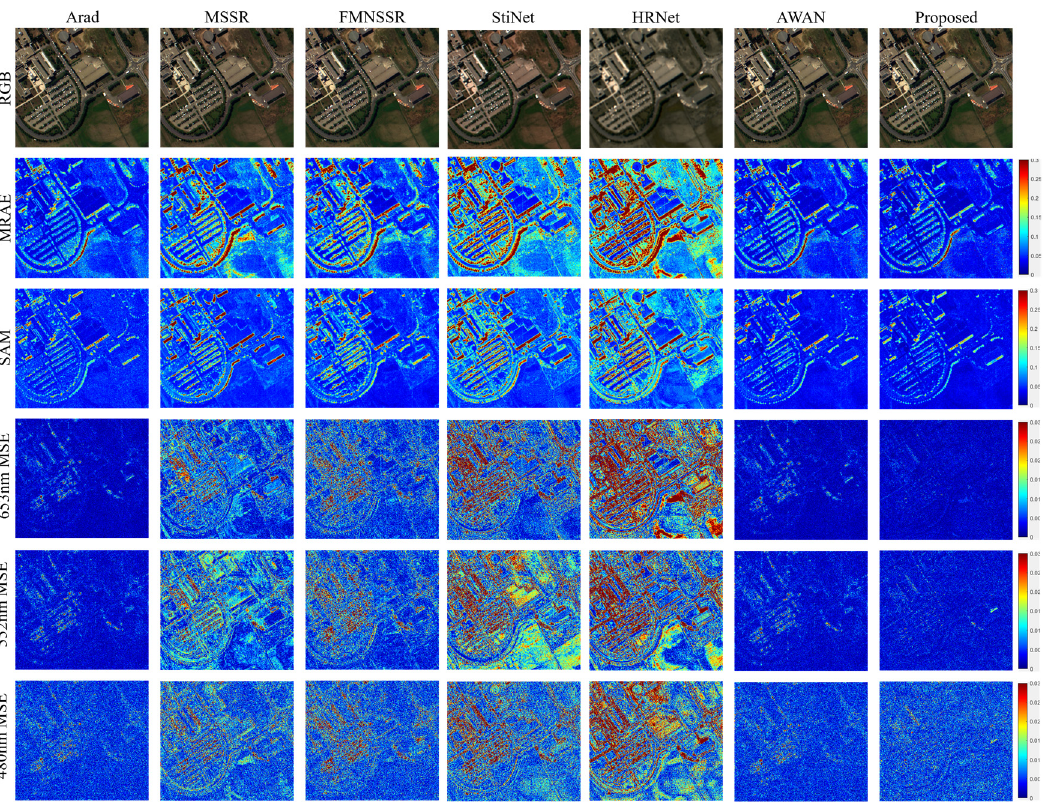
Figure 7. Visual comparison of the results for different methods on the Pavia University data set.